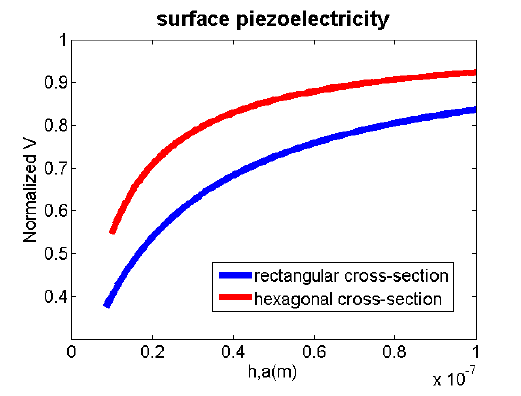
Fig. 3 . The normalized critical voltage with surface piezoelectricity versus the thickness h and side a. Figures 2 and 3 indicate that, when a and h are greater than 100 nm, the normalized critical voltage tends to remain constant. Figure 2 shows that increasing h and a decreased the normalized critical voltage in both cross-sections. Figure 3 shows that the normalized critical voltage increased as h and a